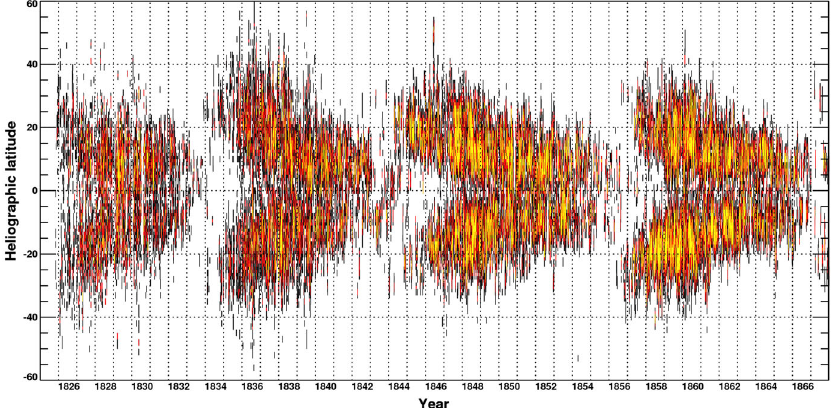
Fig. 2 Maunder butterfly diagram of sunspot occurrence reconstructed by Arlt et al. (2013) for 1825–1867 using recovered drawing of S.H.